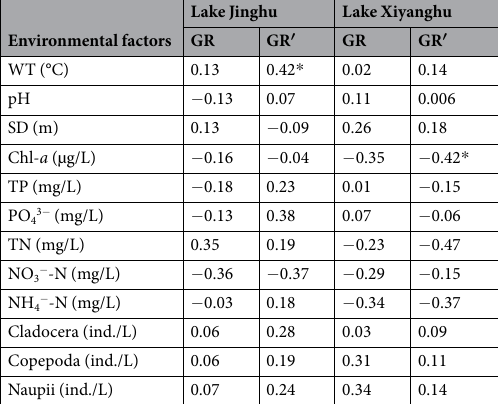
Table 5. Pearson moment correlation between functional indices (GR = the guild ratio, GR ′ = the modified guild ratio) and each environmental factor (WT = water temperature, SD = Secchi disc, Chl- a = Chlorophyll- a ). * p < 0.05; ** p <